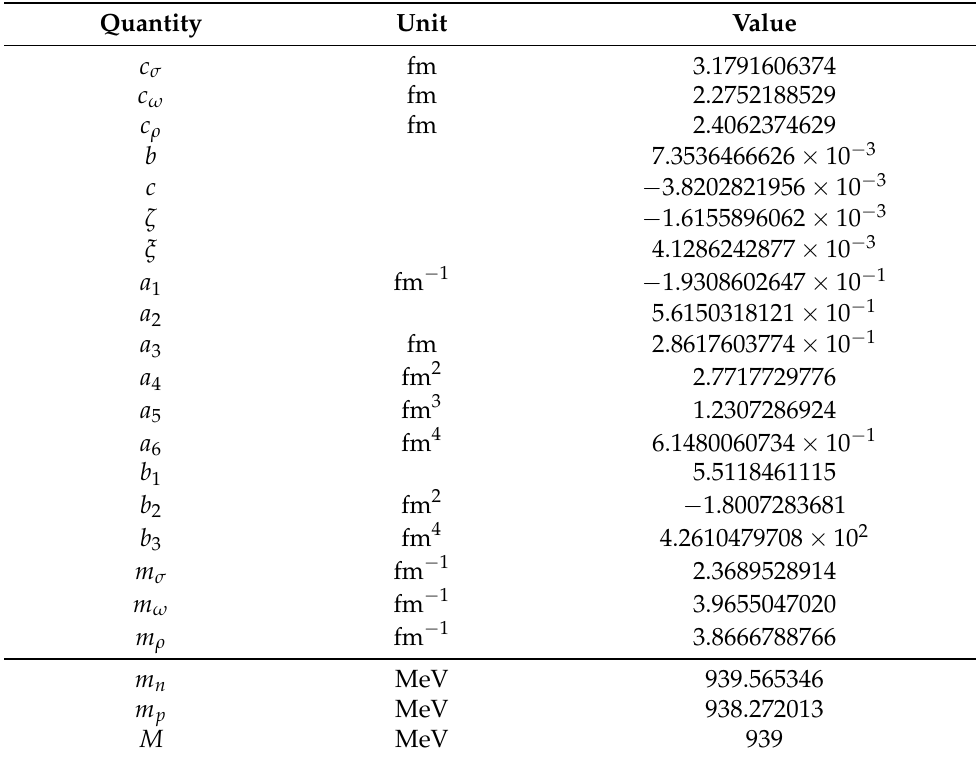
Table A1. SFHo parameter values taken from CompOSE (https://compose.obspm.fr/eos/34, accessed on 27 April 2021). The last three masses are taken from